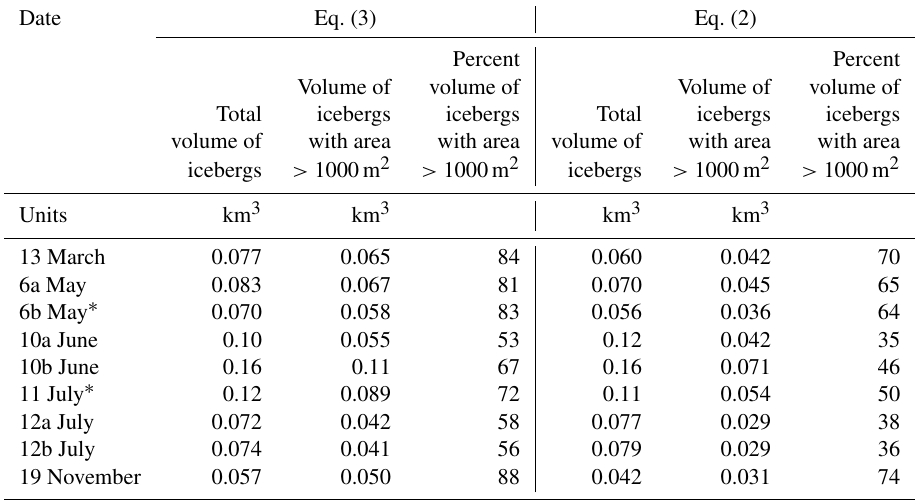
Table 3. Volume of icebergs in Columbia Fjord for each scene, calculated using Eqs. (2) and (3). Date Eq. (3) Eq. (2) Percent Percent Volume of volume of Volume of volume of Total icebergs icebergs Total icebergs icebergs volume of with area with area volume of with area with area icebergs > 1000m 2